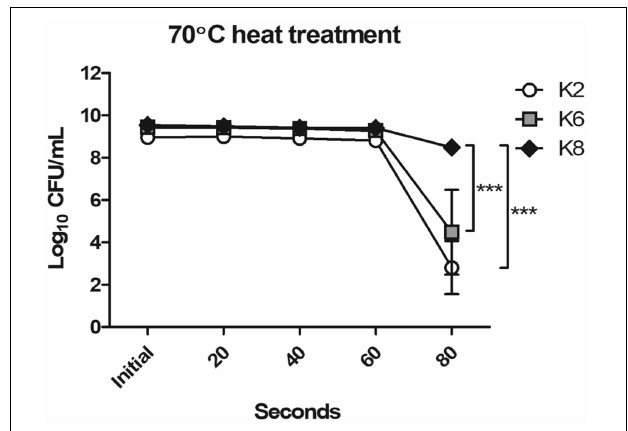
FIGURE 1 | Heat resistance of Lactobacillus plantarum strains ATG-K2, ATG-K6, and ATG-K8. CFU counts of triplicate experiments are expressed as mean ± SEM. Statistical significance between compared groups are indicated as ∗∗∗ p <